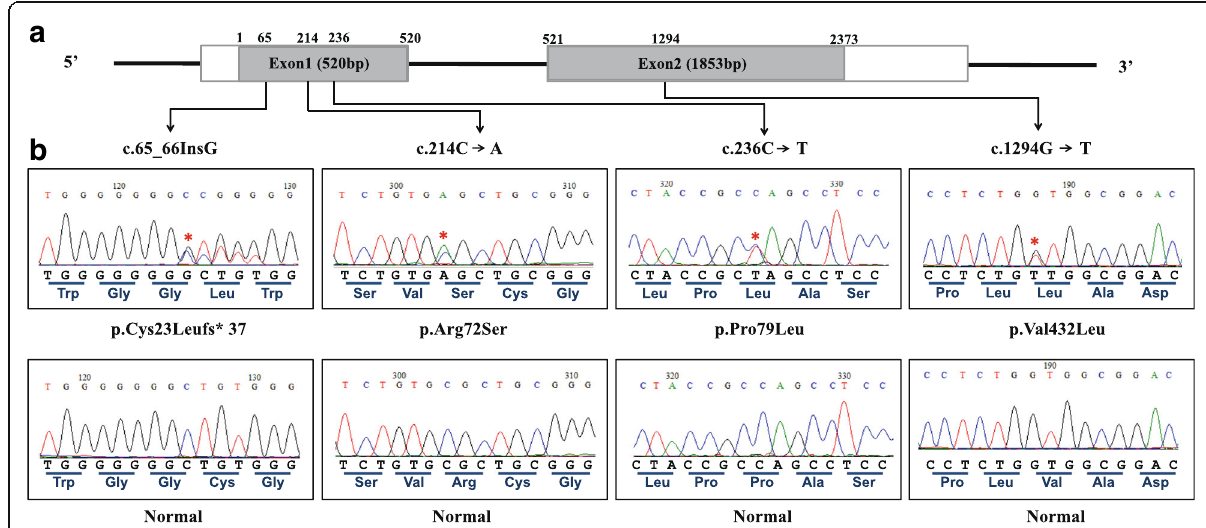
Fig. 1 Identification of variants in the EGR4 gene. a Schematic representation of the EGR4 locus containing the two exons that were sequenced. Coding regions are indicated by a black box. Four nonsynonymous variations (c.65_66InsG, c.214C>A, c.236C>T, and c.1294G>T) identified in Korean patients with oligo/azoospermia are illustrated. b Electropherograms showing the variant sequences. Variants identified in the azoo-/oligozoospermia group (c.65_66InsG, c.214C>A, c.236C>T, and c.1294G>T) are shown in the upper panel. Wild-type sequences from the control group are shown in the lower panel. Red stars indicate the variant